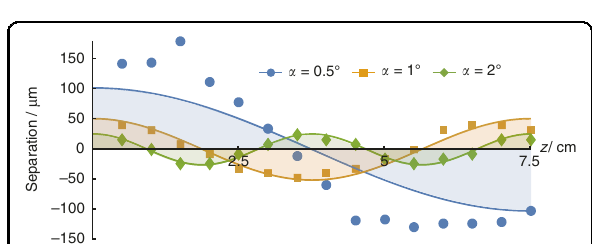
Fig. 6 In fl uence of the input Bessel beam on the spin-dependent oscillated separation. The data points plot the transverse separation between the two spin states of cosine-like PSHE, where the corresponding theoretical curves are depicted by the solid lines. The data for different transverse wave vectors of the input Bessel beams are depicted by blue, orange and green colors, corresponding to the axicons with physical angles α = 0.5°, 1°, and 2°,